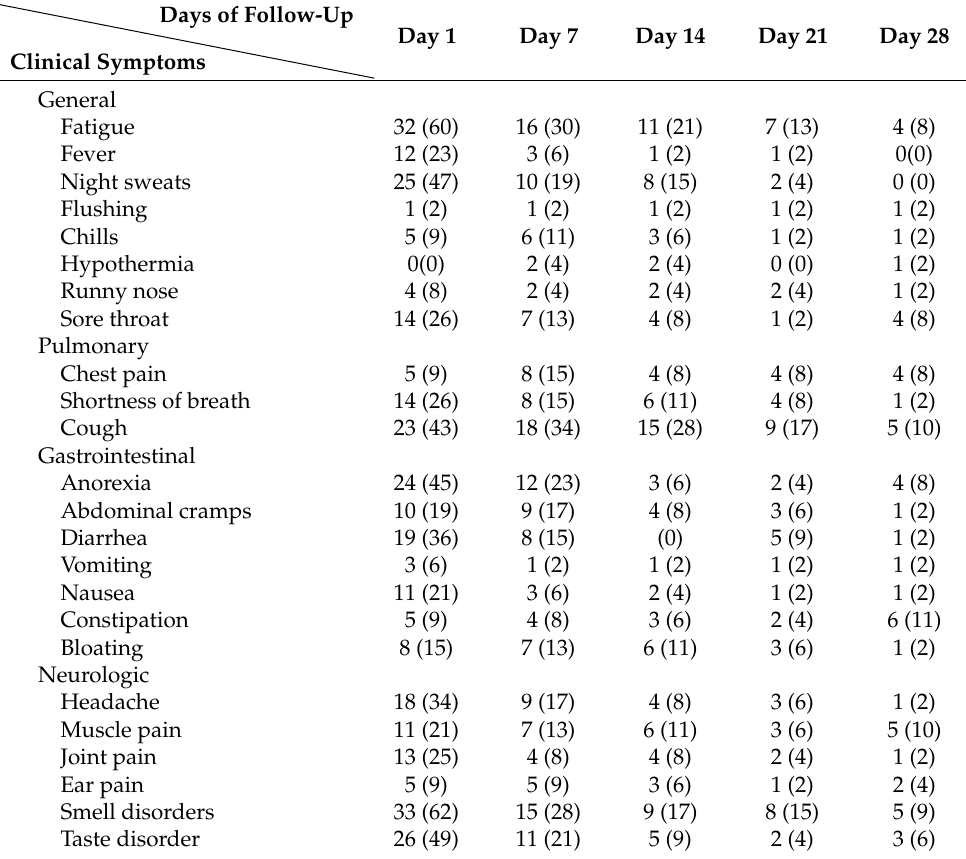
Table 3. Changes in clinical symptoms of COVID-19 among infected patients from day 1 to 28 of follow-up 1 .